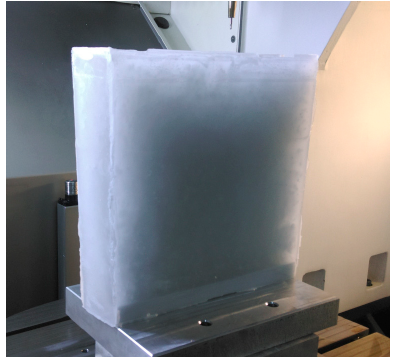
Figure 8. Workpiece with paraffin filling. Micromachines 2017 , 8 , 332